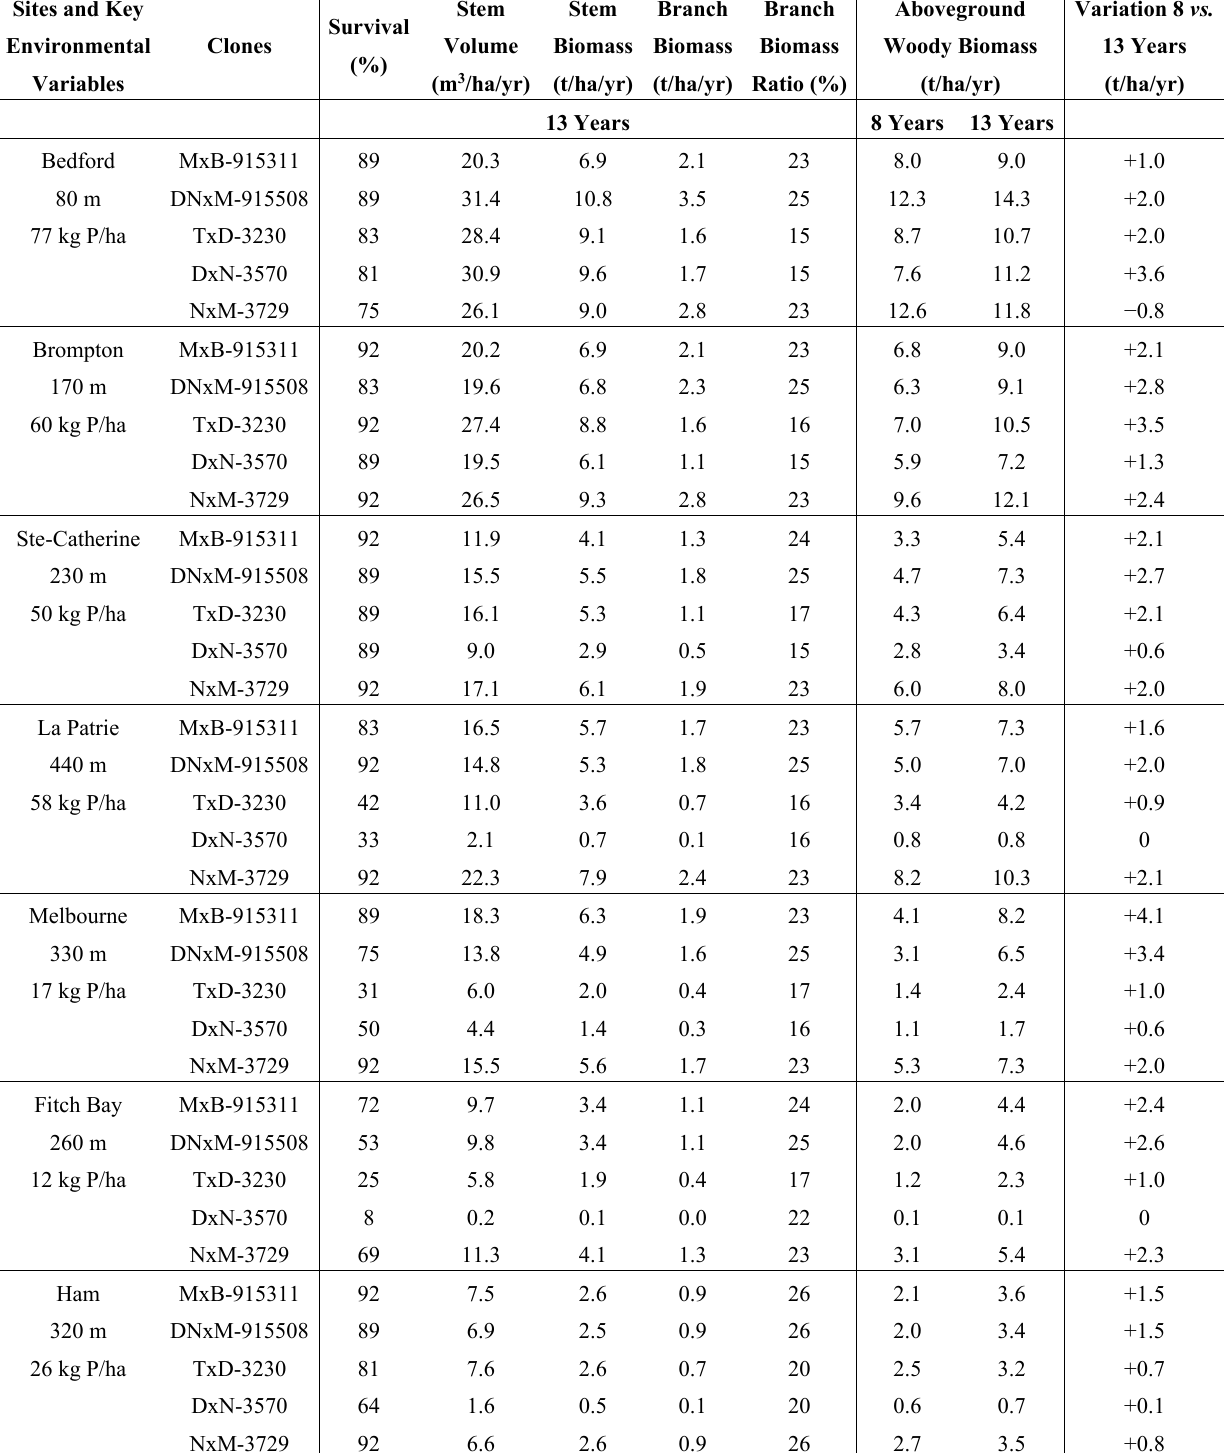
Table 6. Site × Clone interaction for survival and mean annual yield in 13 year-old poplar plantations. The branch biomass ratio is the percentage of woody aboveground biomass that is branch biomass. Woody biomass yield after 8 years is also indicated along with the yield variation between 8 and 13 year-old plantations. Key environmental variables (elevation and soil available P) are indicated for each site (see Truax et al.